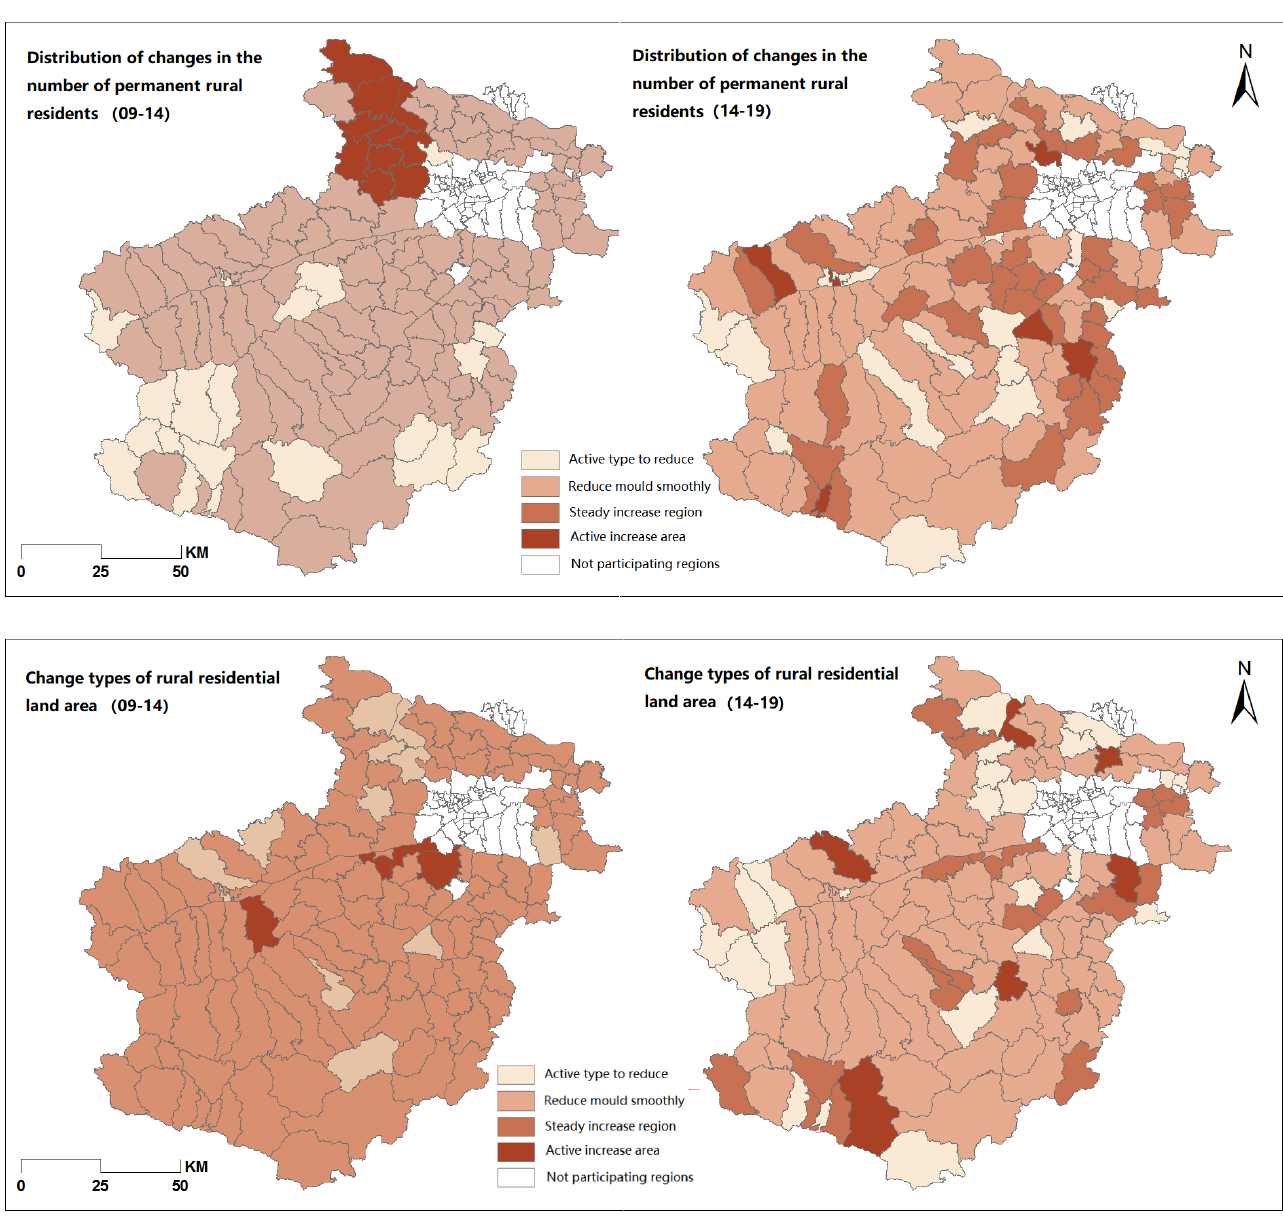
Figure 4. Spatial distribution of the change types of rural population and rural residential land scale.